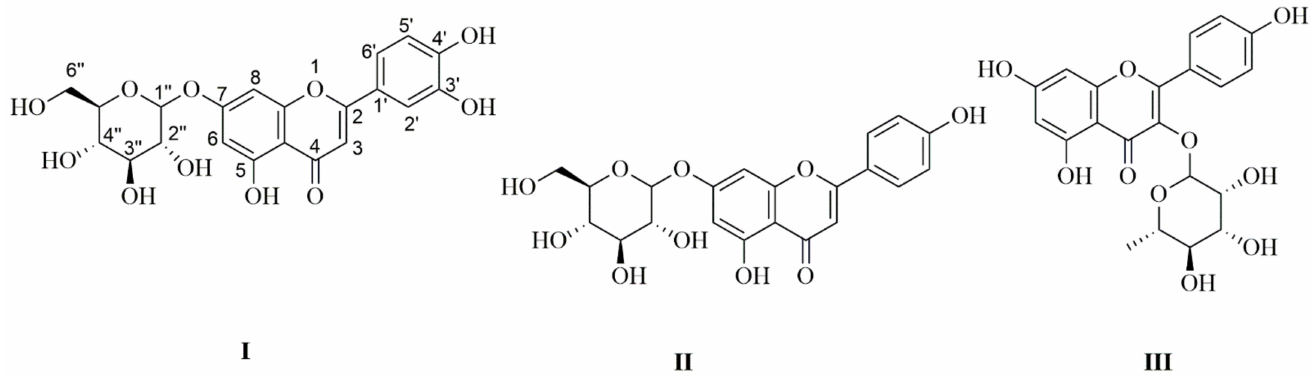
Figure 2. Chemical structures of the compounds isolated from YGME. Compound I : Luteolin-7- O- glucoside, II : Apigenin-7- O - β - D -glucoside, and III : Kaempferol-3- O - α - L